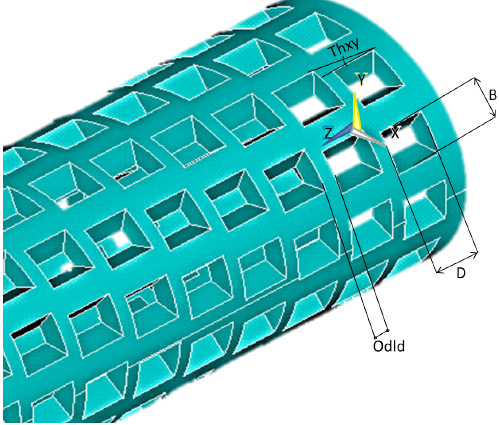
Figure 6. Designation of parameters controlling the form and dimensions of through holes.